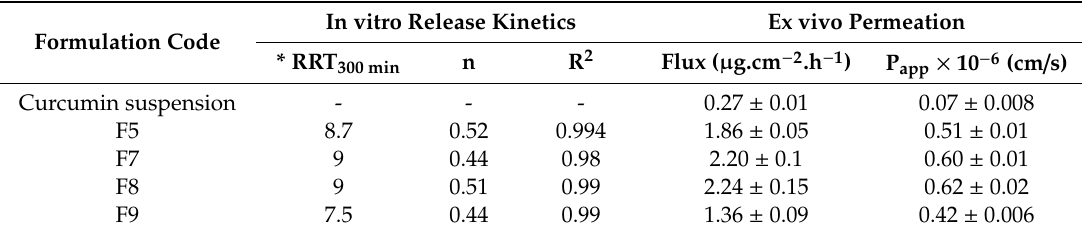
Figure 6. In vitro curcumin release profiles ( A ) and transcorneal permeation profiles of curcumin ( B ) from selected curcumin inserts, data represent means ± SD, n = 3. Table 3. In vitro release and ex vivo permeation parameters for curcumin in situ gelling ocular inserts, data represent means ± SD, n = 3.